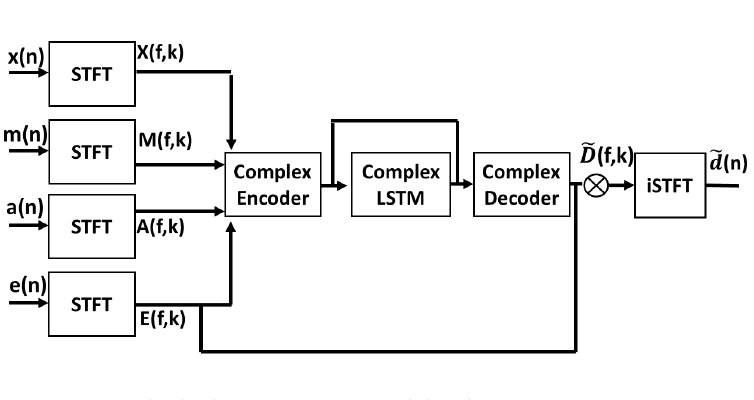
Figure 2. Residual echo suppression model